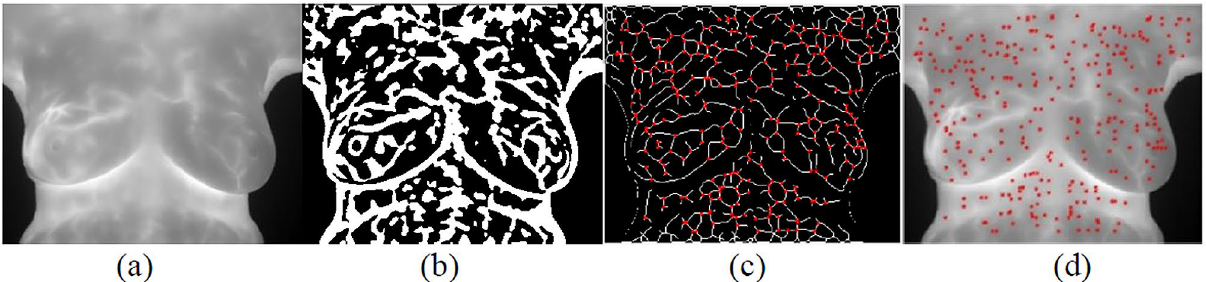
Figure 15. ( a ) An original image; ( b ) the binarization result; ( c ) the skeleton result of the cold pattern; and ( d ) the detection result of the cold pattern.